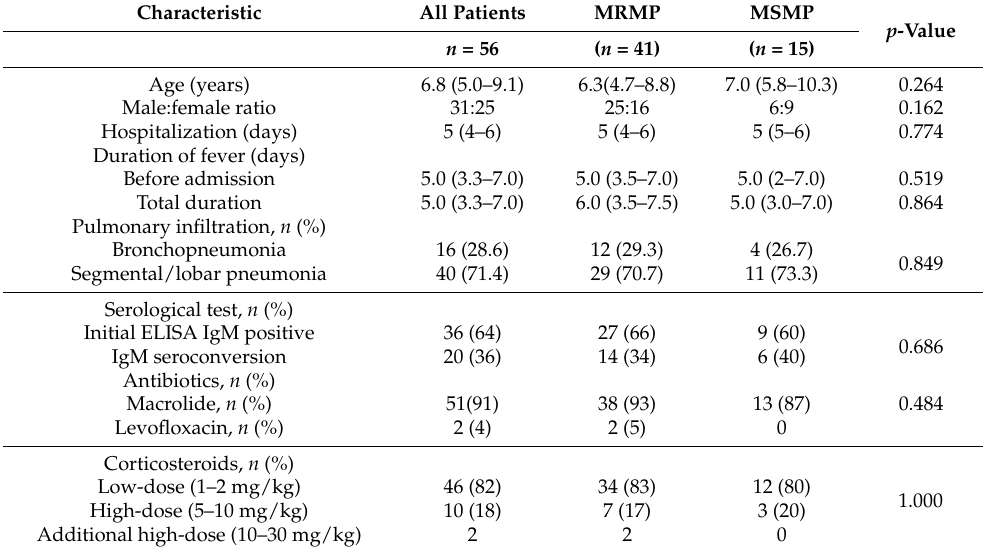
Table 1. Comparing the clinical characteristics of the macrolide-resistant or macrolide-sensitive M. pneumoniae groups.